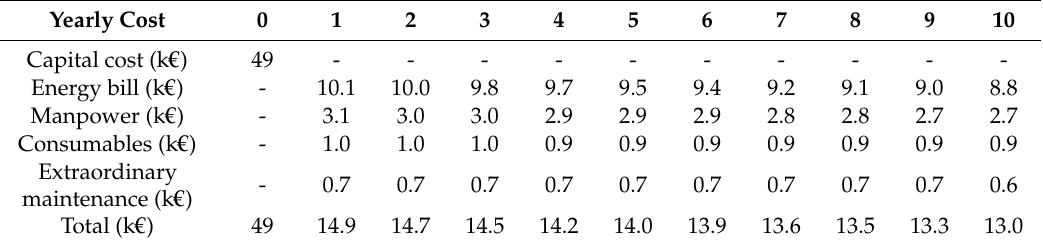
Table 8. Discounted yearly operation and maintenance costs of the pilot